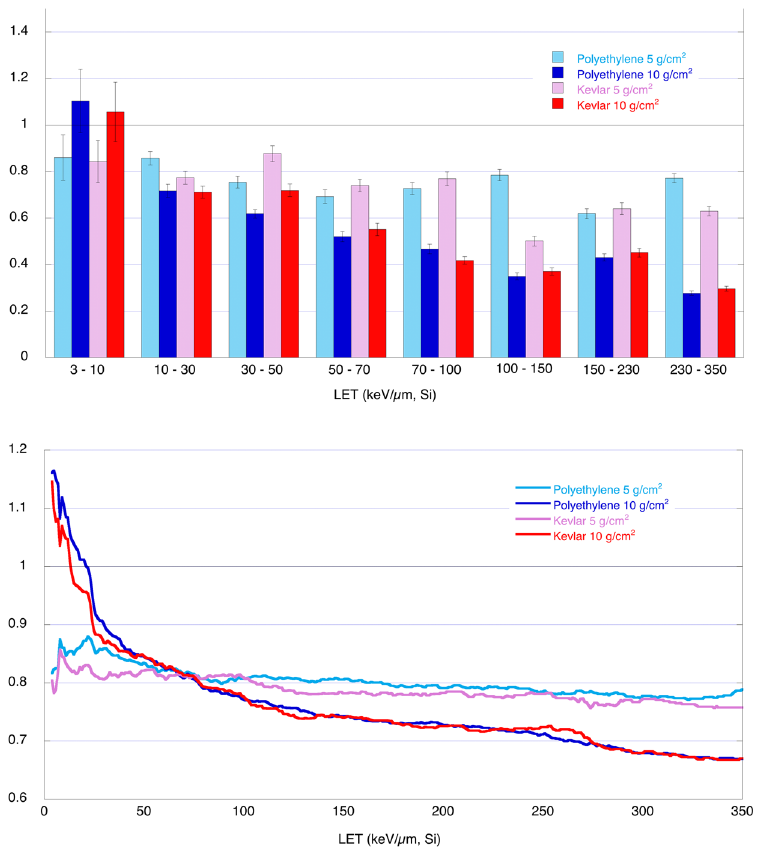
Figure 5. Dose rate ratios and cumulative ratios for different LET ranges. Top: as in Fig. 4 (left side), but in 8 different LET intervals of different width. Bottom: cumulative ratio (ratio of the cumulative dose rate for the shielded measurements to the cumulative dose rate for the unshielded measurements). LET in Silicon. Full colors: tiles with 10 g/cm 2 , patterned colors: 5 g/cm 2 ; blue/cyan: Polyethylene, Red/magenta: